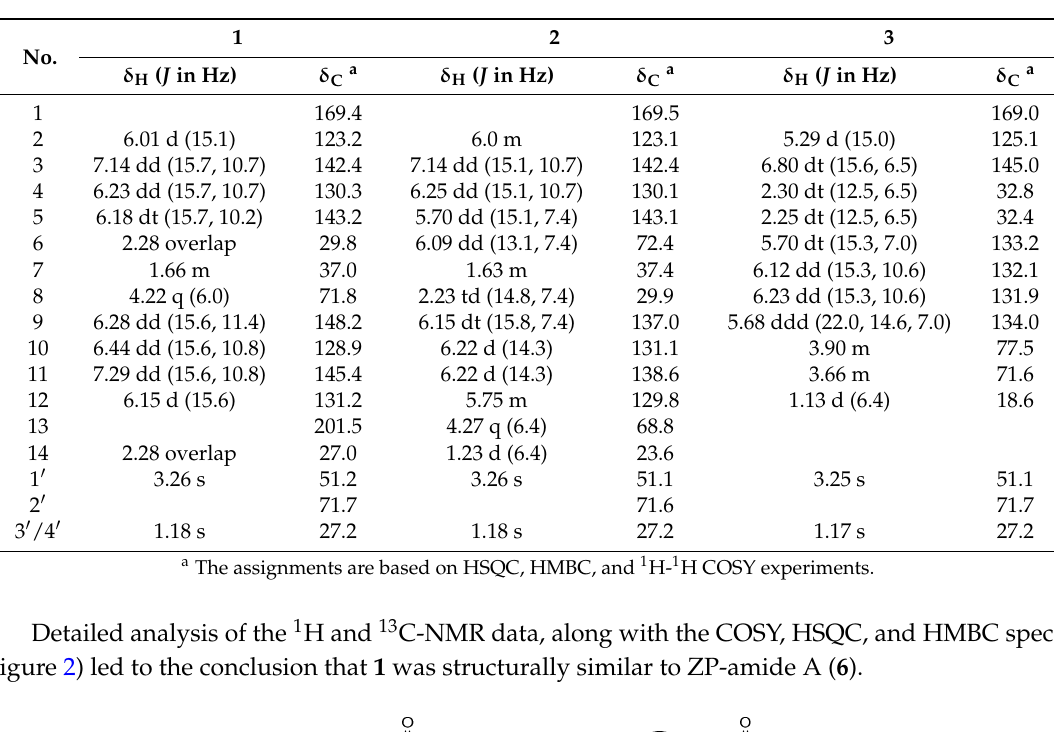
Table 1. 1 H-NMR (500 MHz) and 13 C-NMR (125 MHz) data for 1 – 3 in MeOH- d 4 ( δ ppm).